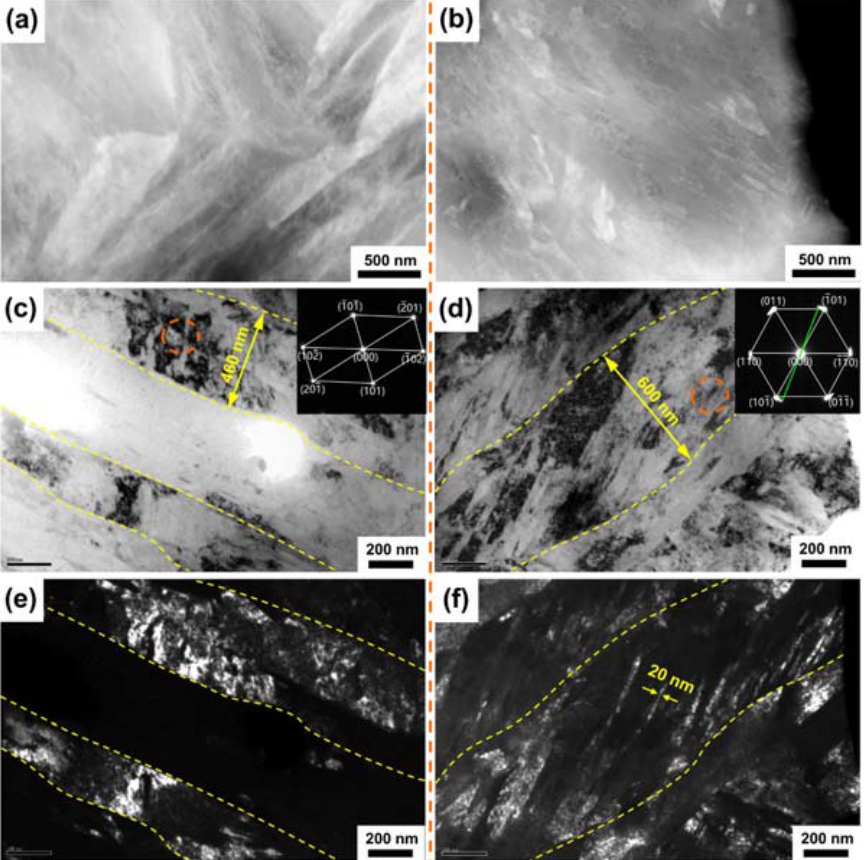
Figure 7. The ( a ) HADDF-STEM, ( c ) bright and ( e ) dark-field images of the base material; the ( b ) HADDF-STEM, ( d ) bright, and ( f ) dark-field images of 10 min USP treated sample at the topmost surface.